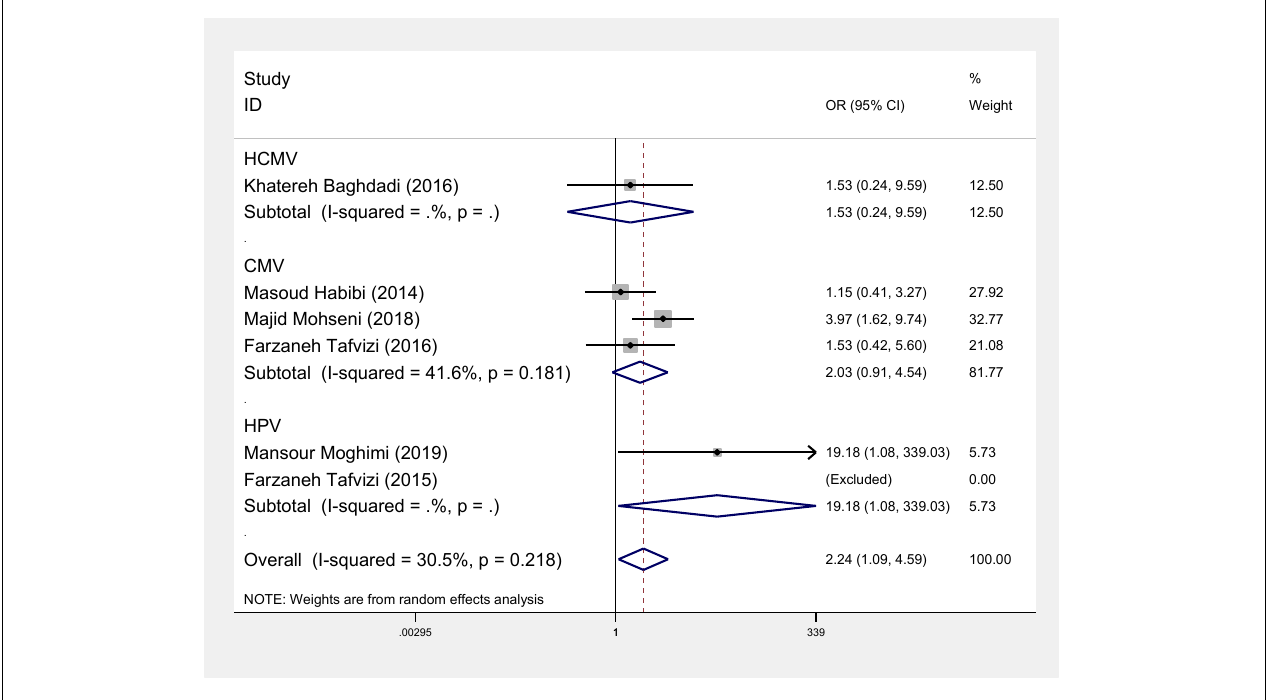
FIGURE 2 | Estimation of odds ratio of male infertility due to exposure to viruses.